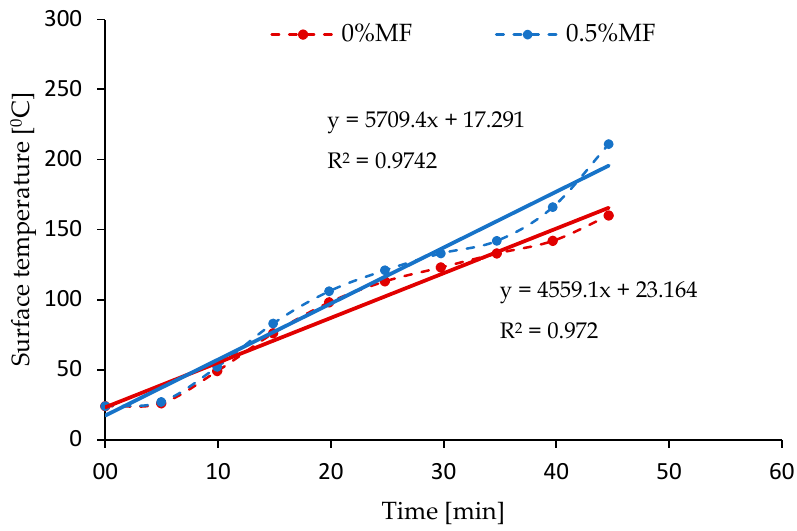
Figure 11. Temperature distribution on the surface of samples during the mini fire-jet test.